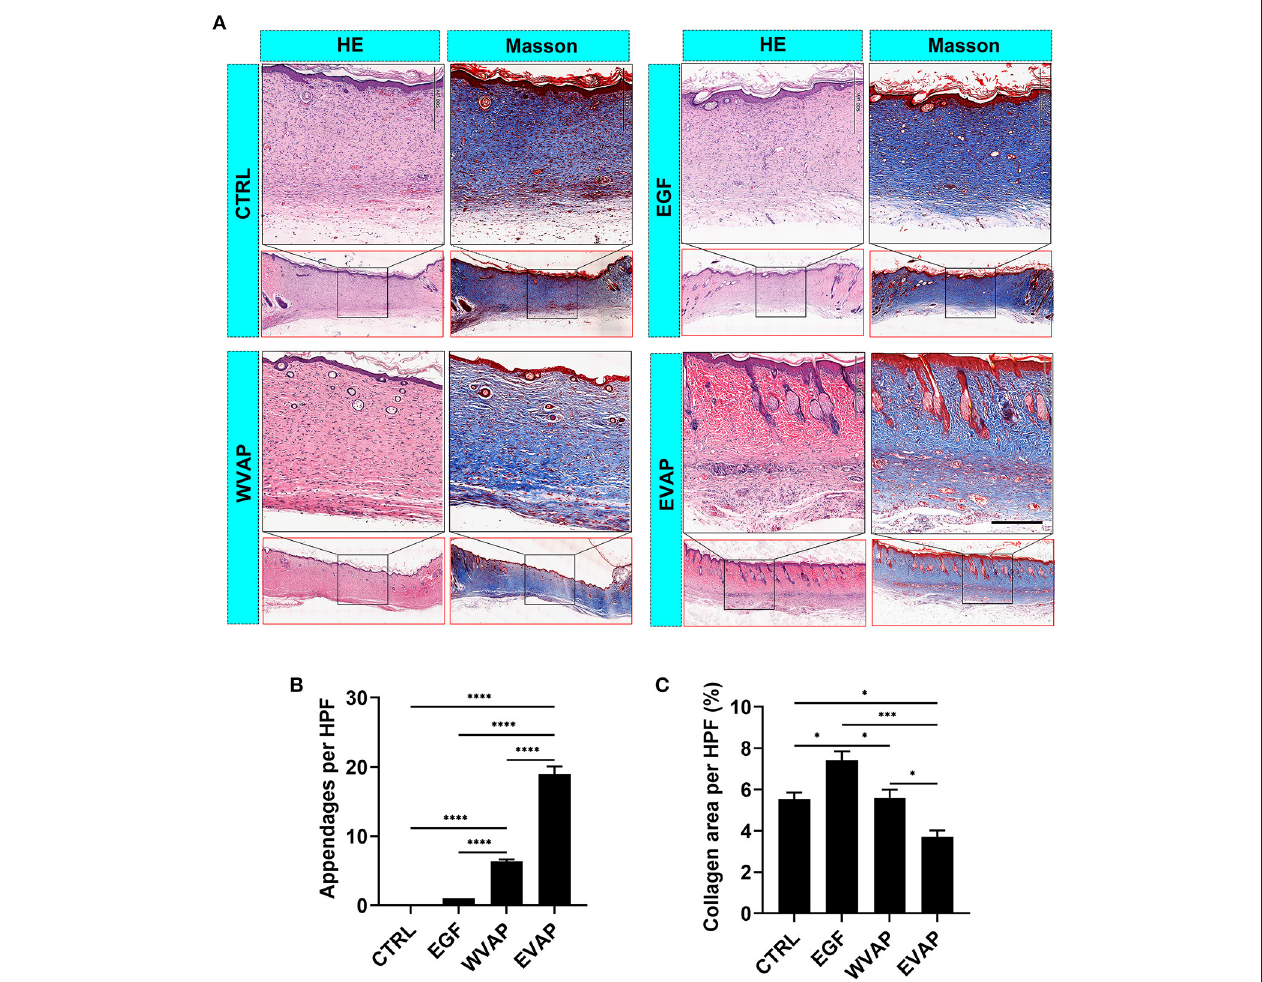
FIGURE 3 | Effects of EVAP on healing quality of the wound tissue in model rats. (A) Histological sections of the healed skin stained either with HE or Masson (scale bar = 200 µ m). (B) Number of skin appendages (hair follicles and sebaceous glands) in the healed skin per HPF. (C) Percentage of collagen area (blue) in the healed skin per HPF. Note that EVAP group had the highest number of cutaneous appendages but the least percent of collagen area compared to the control groups. * P < 0.05; *** P < 0.001; **** P < 0.0001; mean ± SD; n = 3. HE, hematoxylin and eosin; HPF, 20 × high-power field.